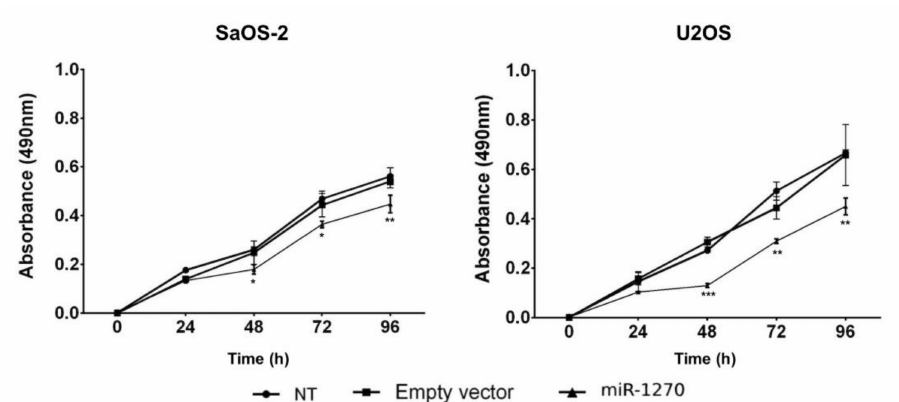
Figure 3. miR-1270 overexpression attenuates cell proliferation. The cell proliferation ability was assessed in non-transfected or transfected SaOS-2 and U2OS cells with miR-1270 mimics or empty vectors using MTT assay. Data are expressed as the mean ± SD from three independent experiments. Non-parametric Mann–Whitney U test was performed. * p < 0.05, ** p < 0.01, and *** p < 0.001. miR-1270, microRNA-1270.